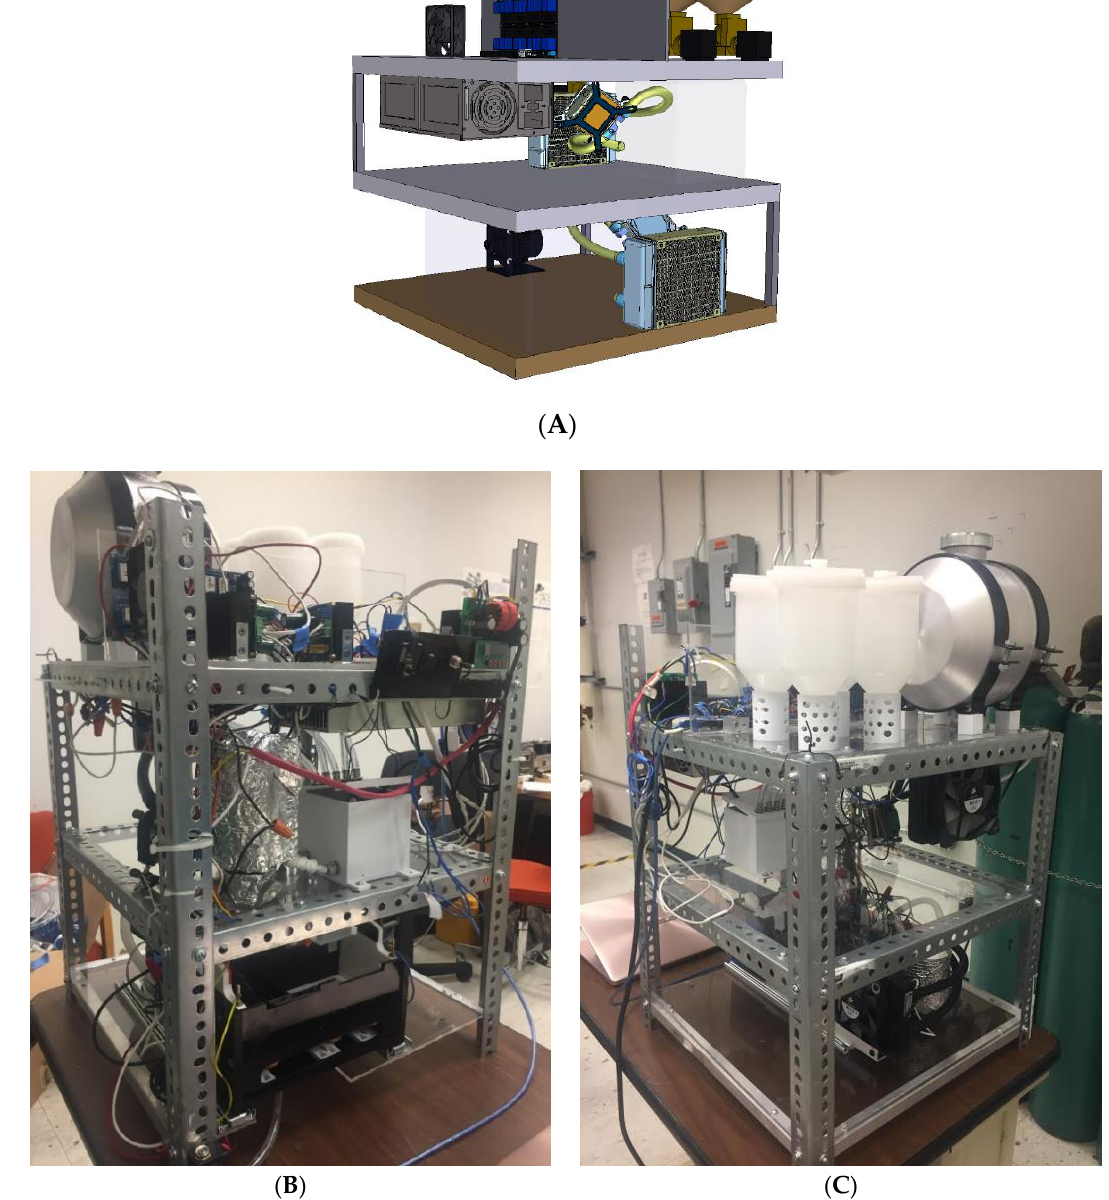
Figure 5. ( A ) Conceptual design and ( B ) the front view and ( C ) the back view of the operational model of the automated high-throughput comet assay device. The automated comet assay system is comprised of four levels. In Figure 5 ( A ): the top level of the device consists of solution tanks and a water tank, each with its own solenoid valve; the middle level contains a microcontroller ‘Arduino mega’; and the lowest level contains all the other electronics, and a power supply. As the process begins, the valves under the tanks open, and the liquids flow into the cooling box that is in the next level down. The next level comprises a custom-made, high-density polyethylene cooling tank and a cooling loop that combines a pump, a CPU liquid cooler to dissipate heat, and a Peltier cooler. The cooling tank is packed with two float sensors and a temperature sensor. Once the fluid is cooled to 4 °C, the cooling tank is opened, and the chilled fluid flows into the electrophoresis tank that is on the bottom level. Another cooling loop around the electrophoresis tank maintains the temperature at 4 °C throughout the process.